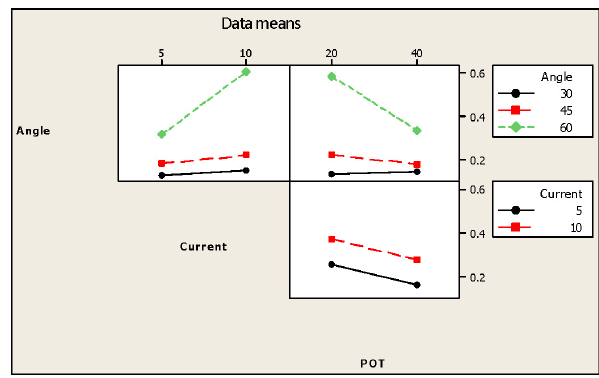
Figure 12. Interaction effect plots of mean wire